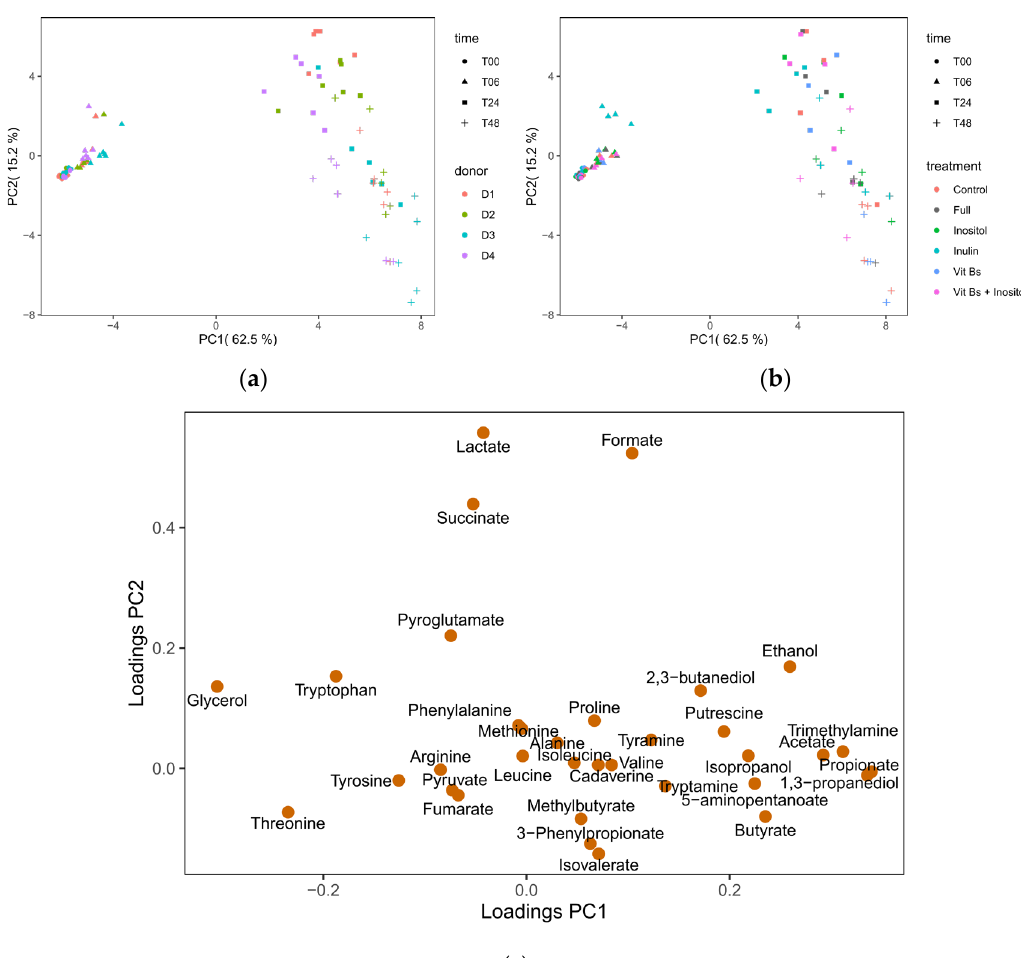
Figure 5. PCA analysis of metabolomic profiles of in vitro fermentation media. Effects of nutrient or nutrient combinations were examined in four microbiota backgrounds (D1, D2, D3 and D4 corresponds to donor 1, 2, 3 and 4). Samples were collected at times 0, 6, 24, and 48h (T00, T06, T24 and T48) from batch fermentation experiments. Each dot in the PCA score plot represents an individual, and the shape and color of symbol denote the time point, fecal donor, or nutrition treatment ( a , b ), respectively. The loading plot highlighted the metabolites influencing distribution in PCA score plots ( c ).